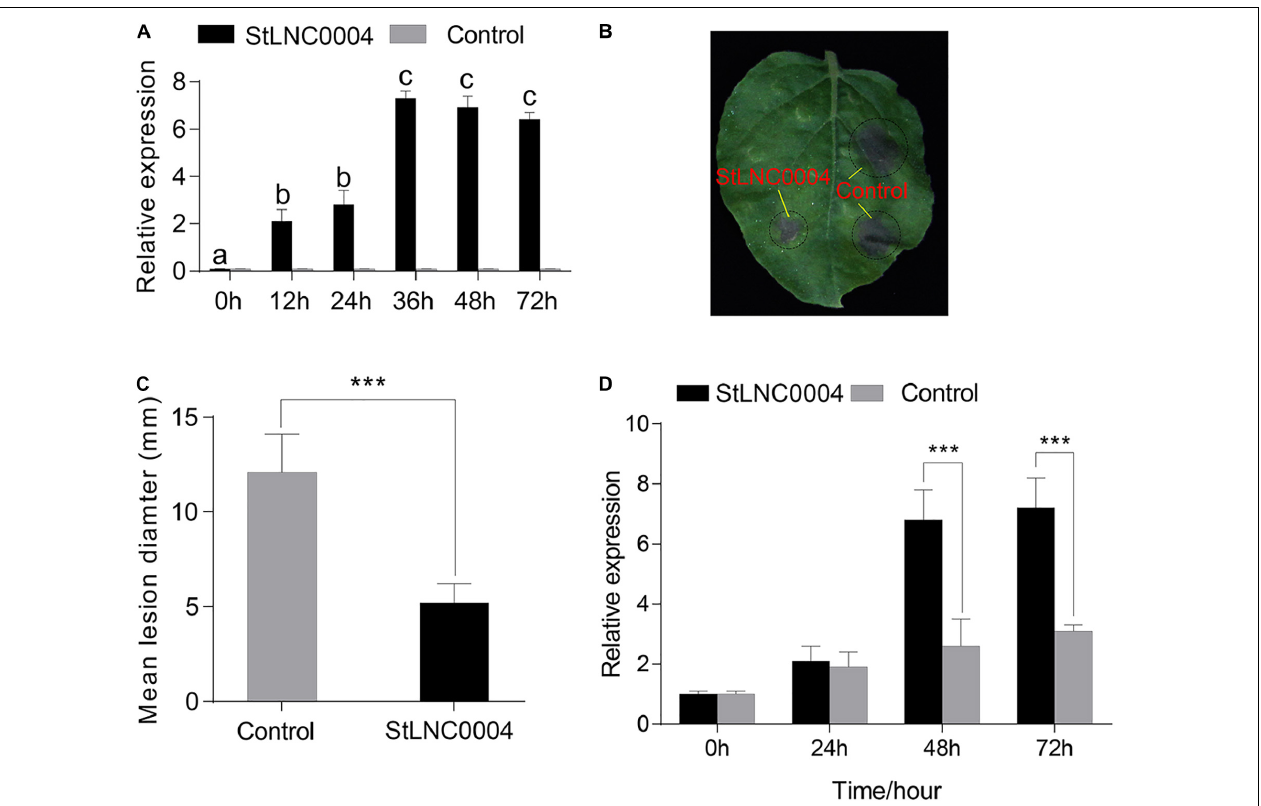
FIGURE 7 | Transient expression of StLNC0004 inhibits P. infestans colonization in Nicotiana benthamiana . (A) Quantitative real-time PCR (qRT-PCR) was performed to identify the expression level of StLNC0004 in N. benthamiana . StLNC0004 and Control represent the N. benthamiana containing pROK II: StLNC0004 and pROK II, respectively. (B) Representative leaf images of P. infestans lesions following expression of StLNC0004/Control in N. benthamiana . (C) Mean P. infestans lesion diameter (mm) on sites of transient expression of the StLNC0004 and Control. (D) QRT-PCR identified the expression level of NtEXT , the ortholog of StEXT , the target gene of StLNC0004 . Different letters in the columns represent a significant difference in the qRT-PCR results between StLNC0004 and Control ( P ≤ 0.05). *** represents a significant difference between StLNC0004 and Control ( P ≤